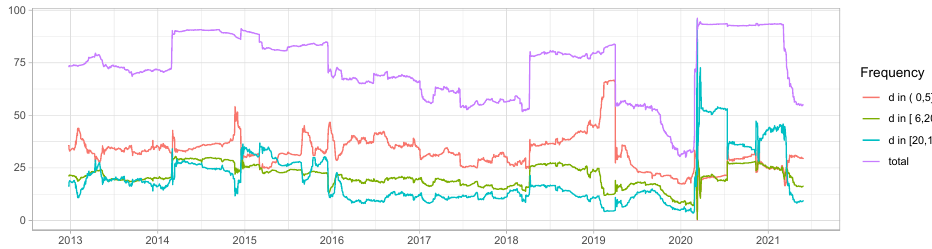
Figure 3. Dynamic frequency connectedness. DY-BK